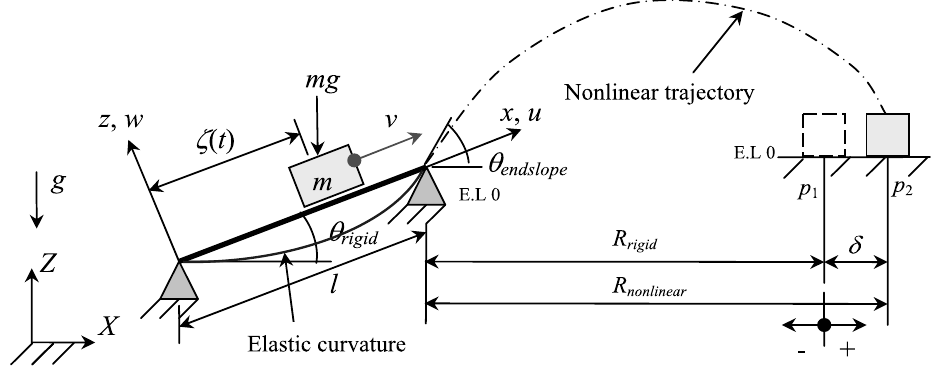
Fig. 10. Prediction of a planar motion of a simple projectile using different